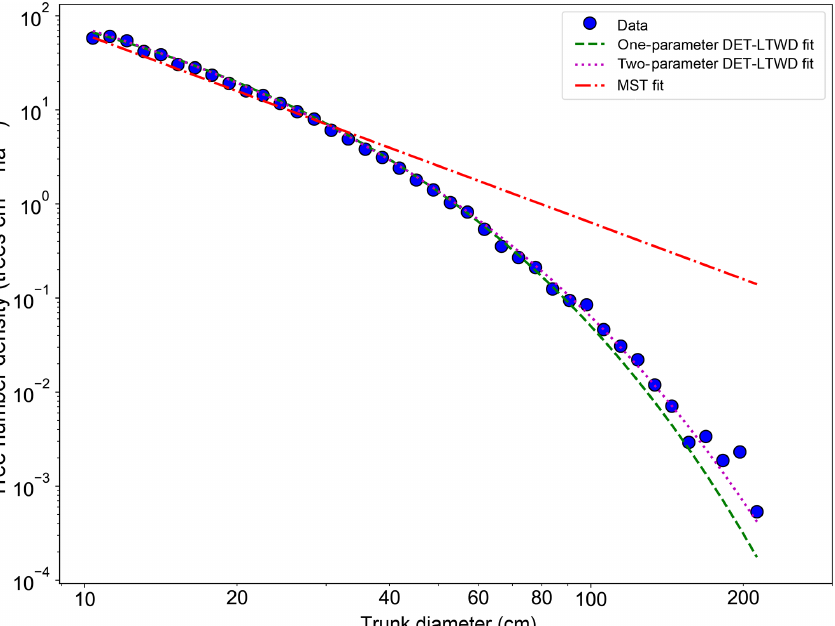
Figure 3. Fit to the trunk diameter size distribution for all South American RAINFOR plots as one large dataset. The blue circles show the binned data and the lines show the fitted distribution for each